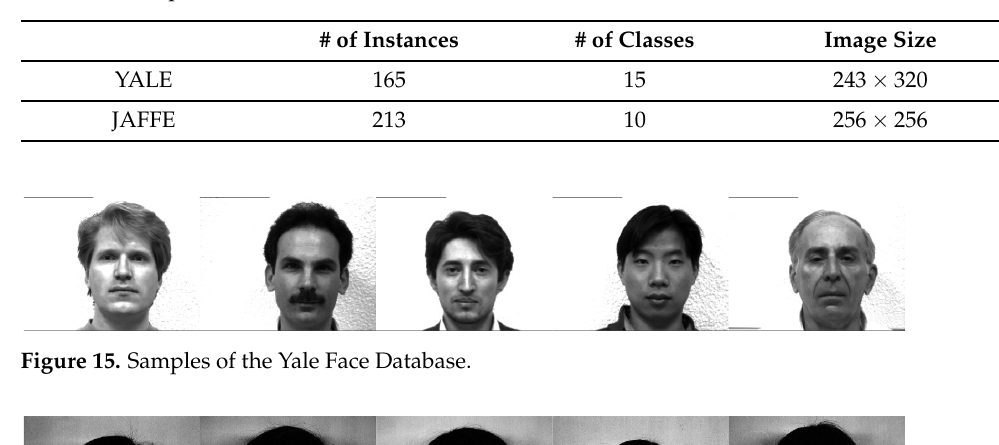
Table 1. Description of the datasets.